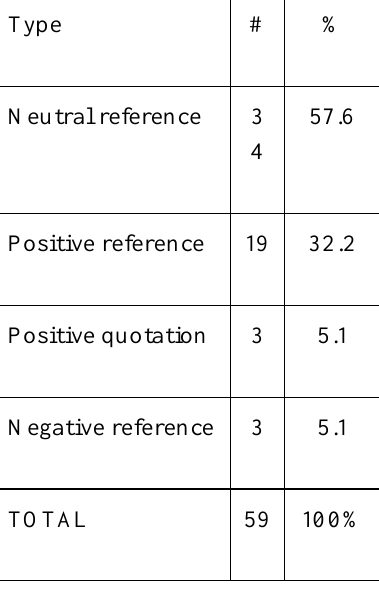
Type, Frequency, and Proportion of References in Applications/Replications